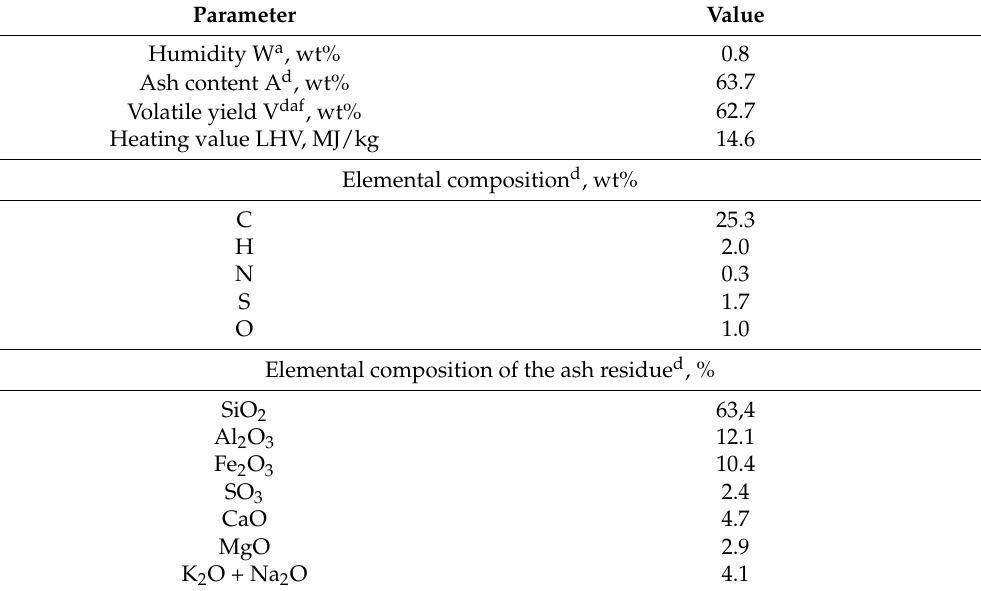
Table 2. Physical and chemical characteristics of